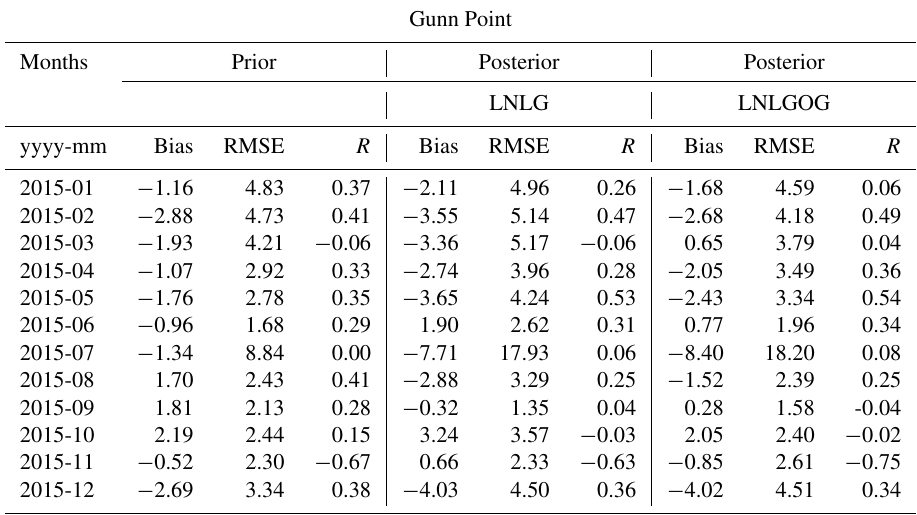
Table H1. Analysis of the residual between CMAQ prior and posterior simulations and the Gunn Point site for 2015: averaged bias, RMSE and Pearson’s coefficient ( R